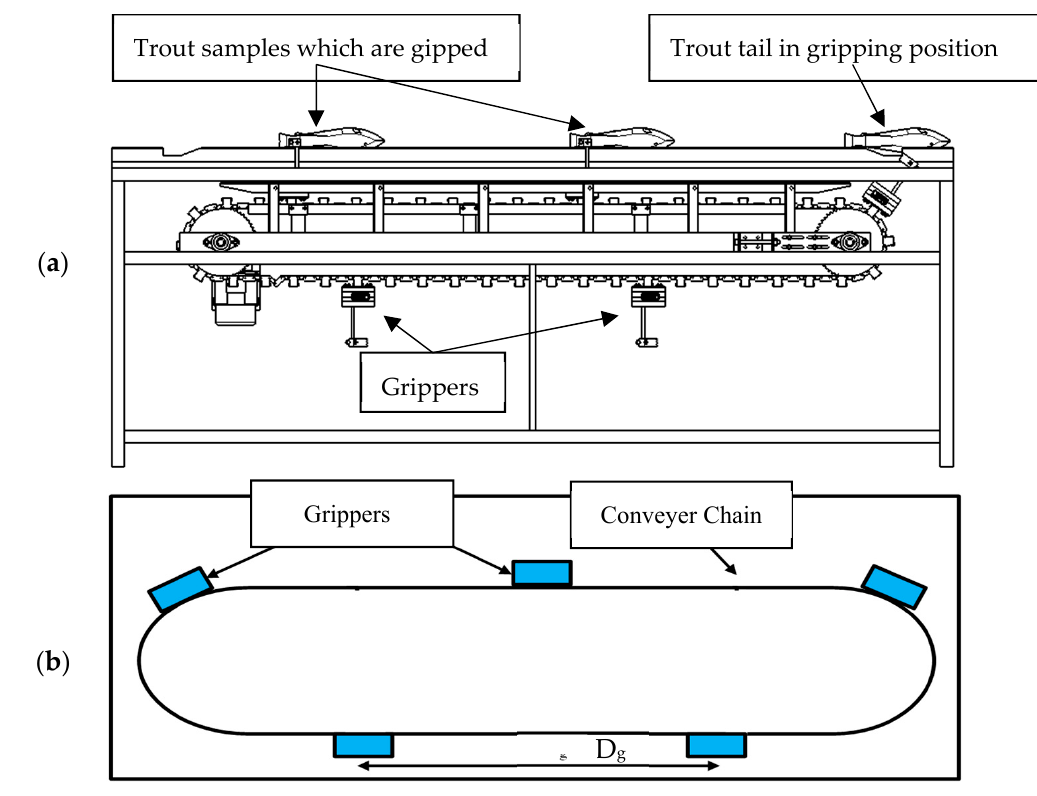
Figure 4. ( a ) System sketch, and ( b ) conveyor chain and the grippers with a distance “D g ” between the grippers.